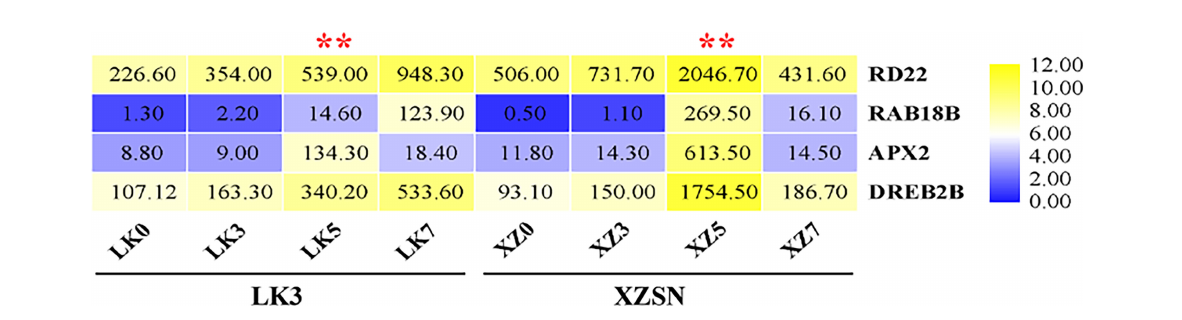
FIGURE 4 FPKM value of four drought-responsive marker genes in LK3 and XZSN at different treatment points. ** represents the time point of response to drought stress.